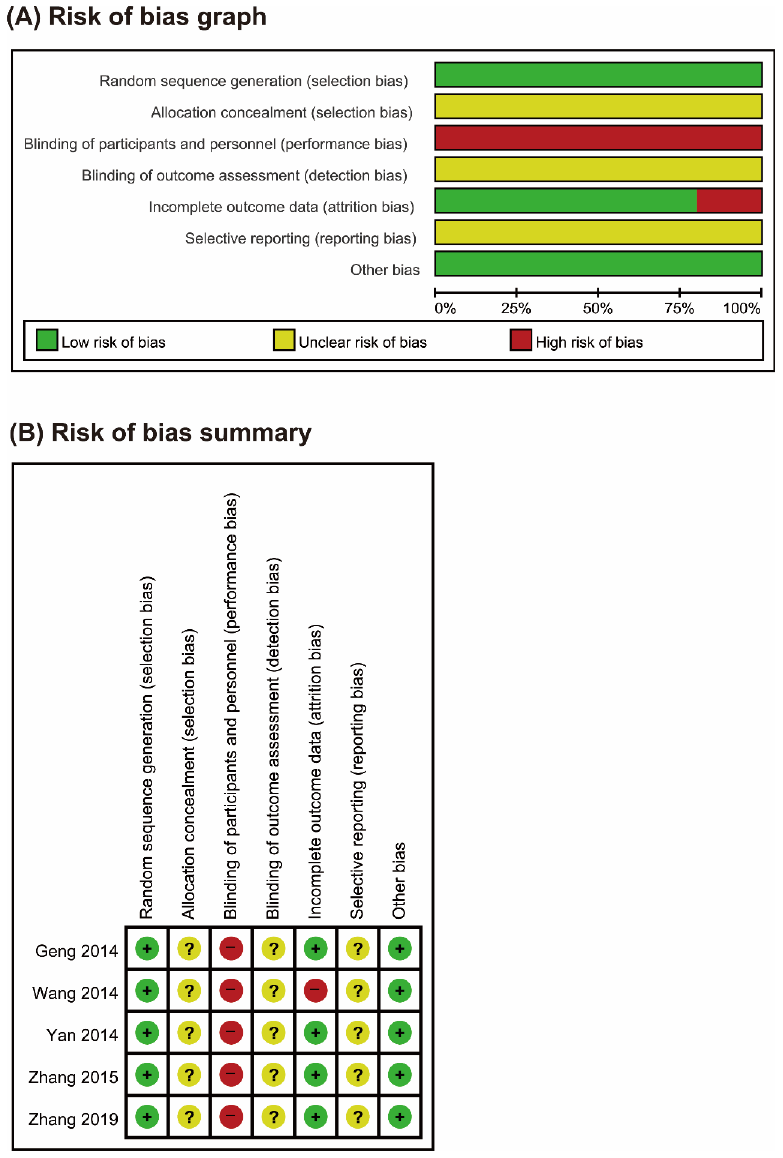
Figure 2. Risks of bias. ( A ) Risks of bias of the included studies. The authors reviewed each item’s risk of bias for each included study. ( B ) Risks of bias of individual studies. +: low risk of bias; − : high risk of bias; ?: unclear.